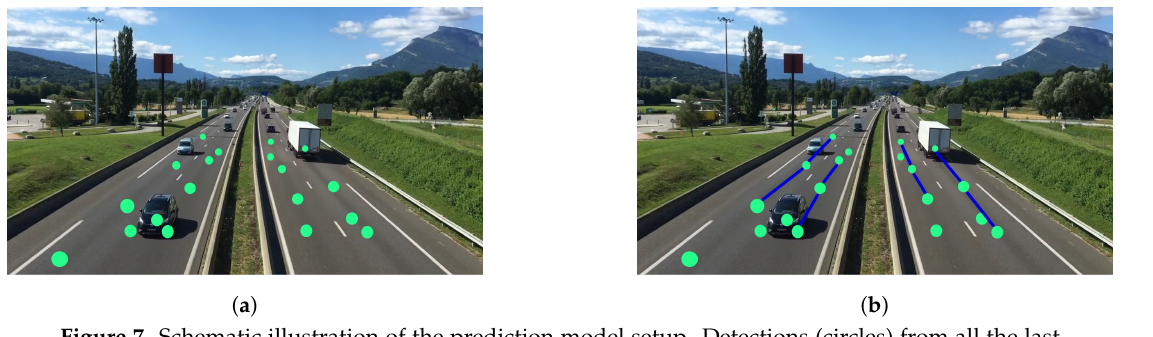
Figure 7. Schematic illustration of the prediction model setup. Detections (circles) from all the last frames are saved ( a ). The prediction model tries to associate these data points to get driving paths (lines) based on specific limitations ( b ). Source [27].